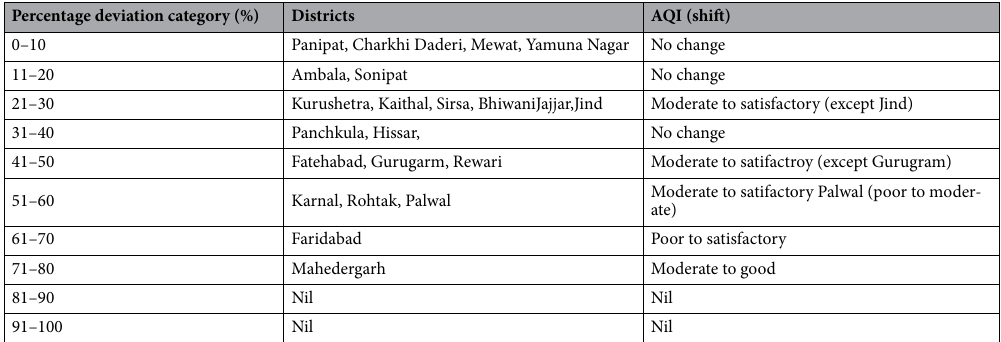
Table 1. Depict the change in air quality